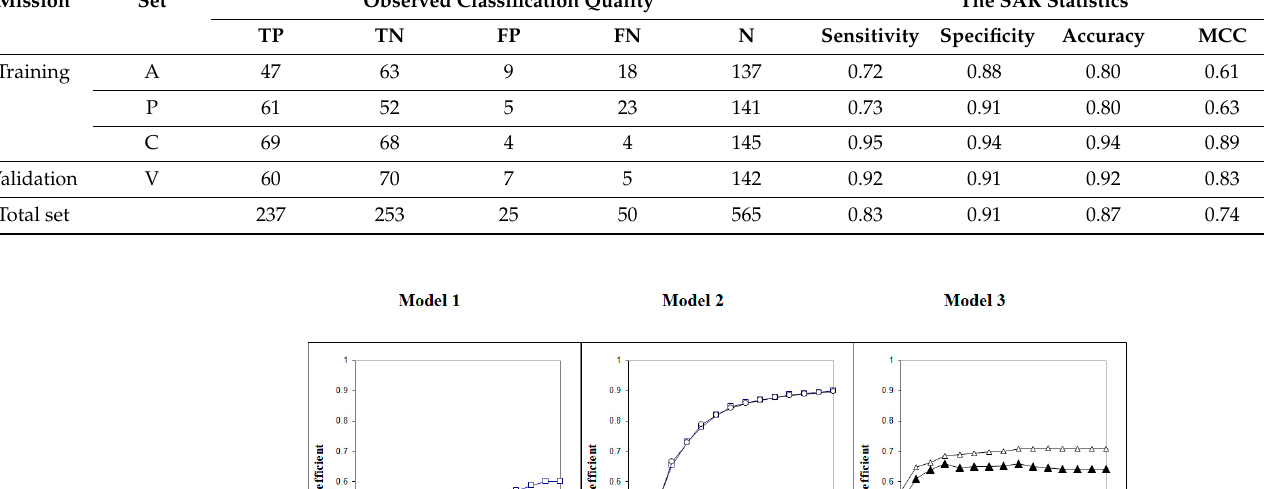
Table 4. The statistical quality of model observed for the third optimal descriptor with the second version of the Monte Carlo optimisation of the correlation weights.